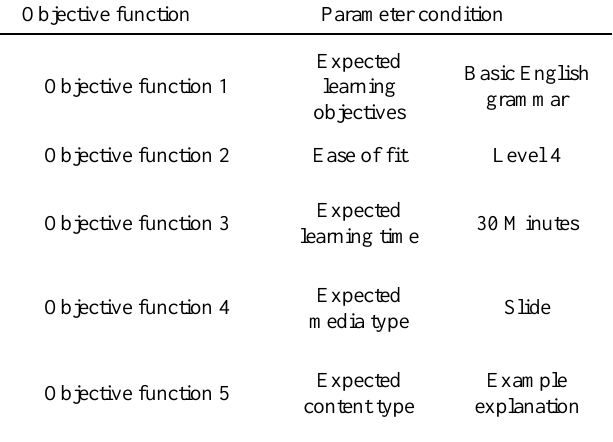
Table 1. initialization parameter conditions